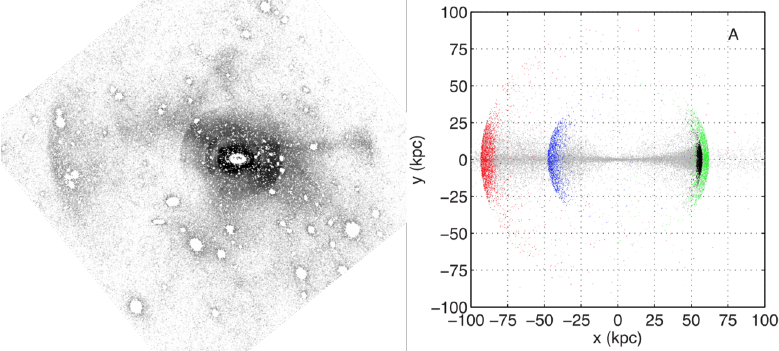
Figure 1. The observed shells around NGC 3923 (left panel) compared with the distribution of particles stripped from an accreting satellite galaxy on a radial orbit in an N-body simulation (right panel; reproduced from Figure 3 of [4]). The underlying light of the galaxy has been removed from the image using the ARCHANGEL ellipse-fitting package [9]. The simulation is of a 2.2 × 10 8 M (cid:12) satellite falling into a spherical potential with total mass of 2.7 × 10 12 M (cid:12)